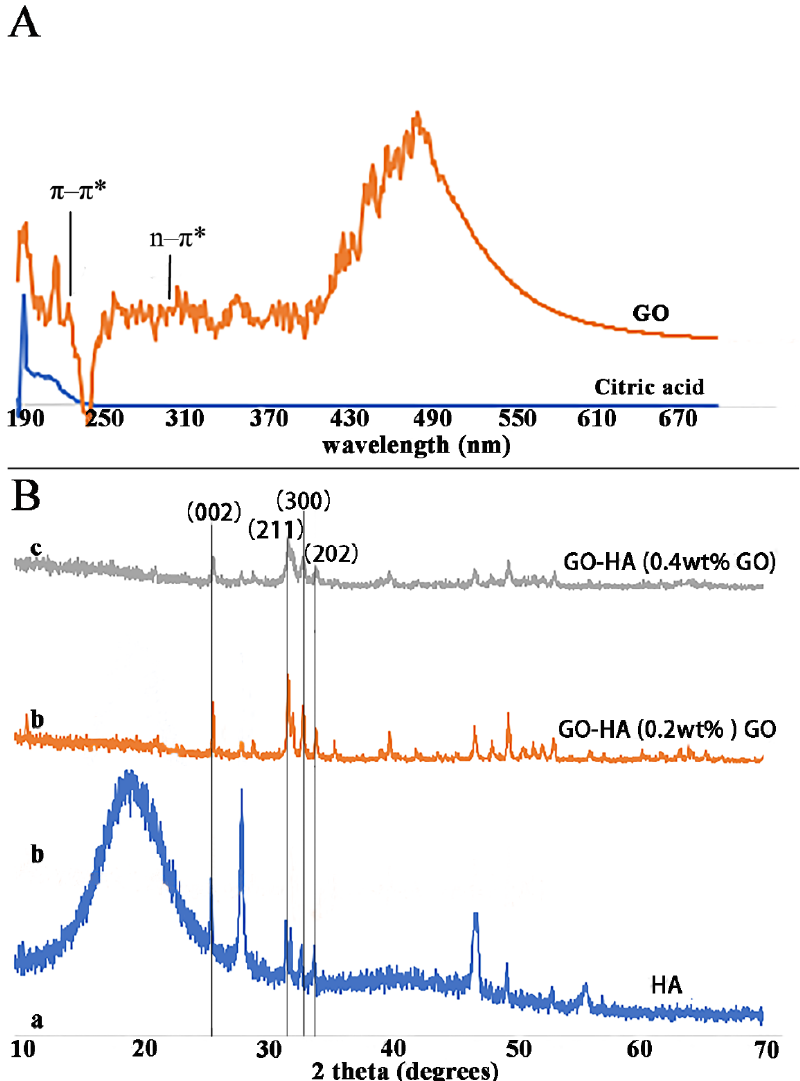
Figure 2. ( A ) Ultraviolet-visible (UV-visible) absorption spectra of citric acid and graphene oxide (GO); ( B ) XRD evaluation of hydroxyapatite (HA) and GO − HA crystals fabricated with different concentrations of GO.